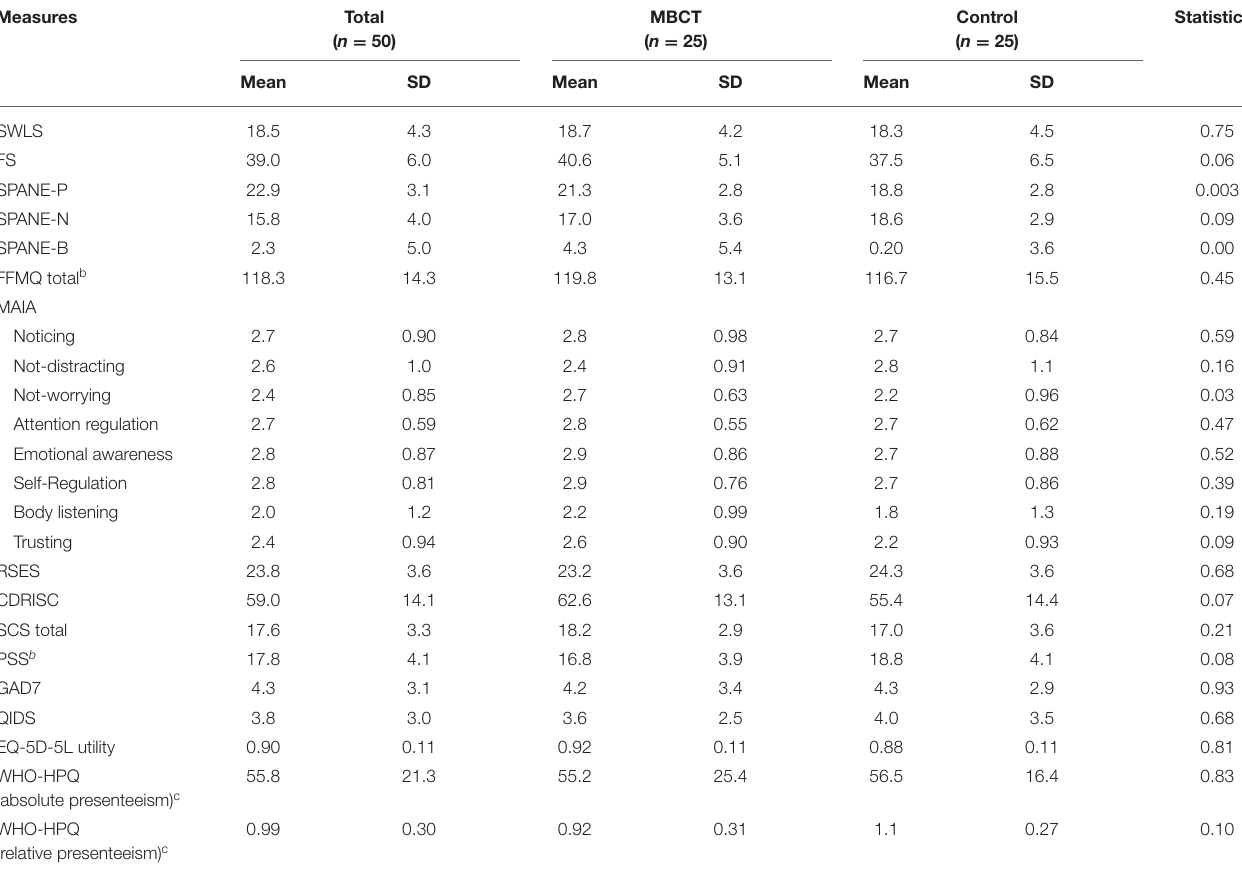
TABLE 4 | Baseline clinical